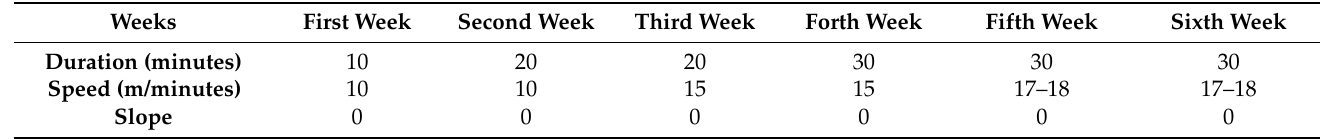
Table 1. Endurance training protocol in different